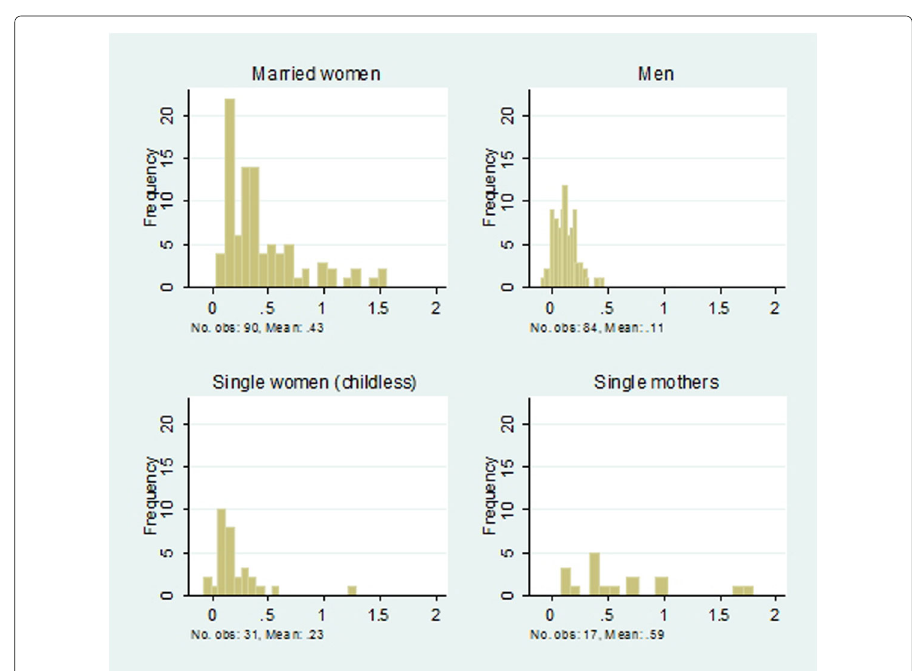
Fig. 1 Distribution of wage elasticities by demographic group